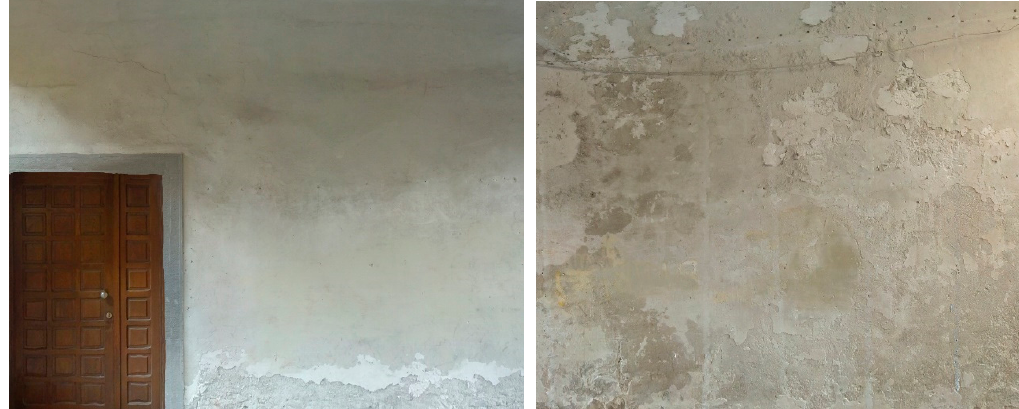
Figure 13. Some orthophotos for the vertical wall ( left ) and the vault ( right ). It is now possible to measure areas and to compute the costs of the interventions.